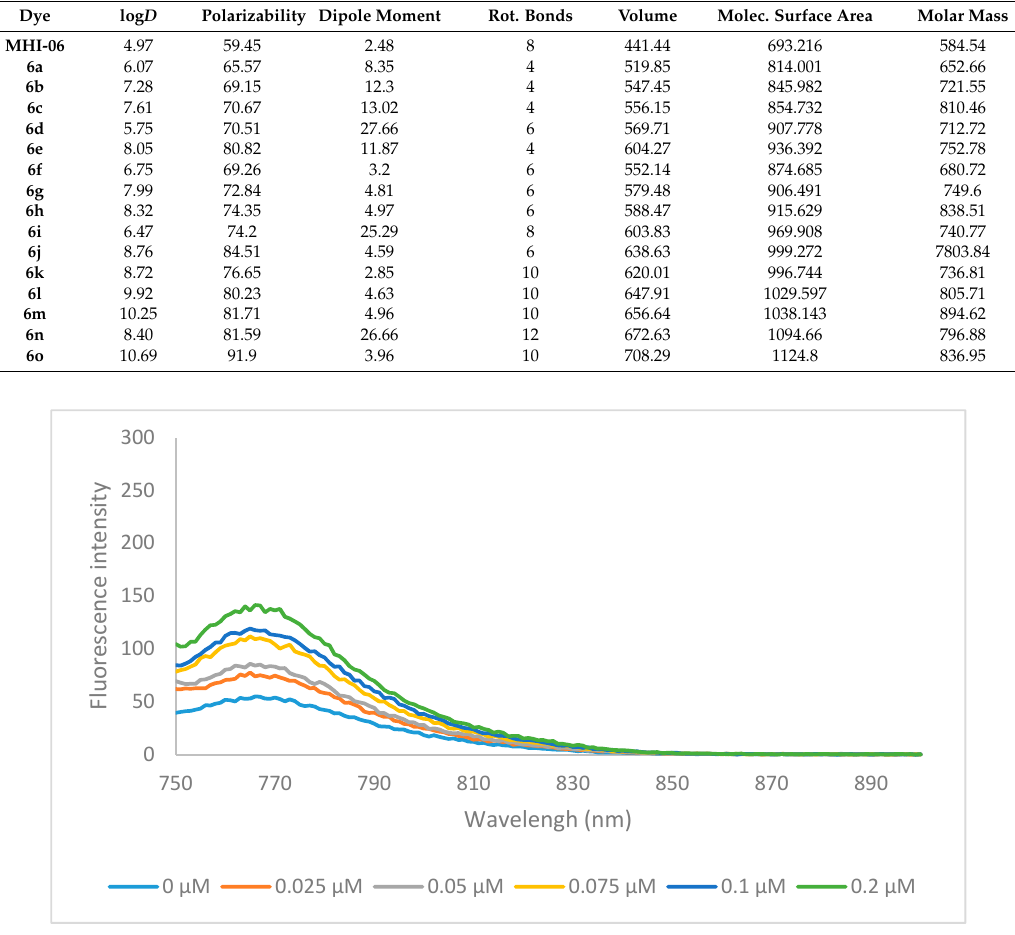
Figure 4. The emission specra of 6a (0.2 μ M) binding with various concentration of HSA, in PBS buffer at excitation wavelength of 740 nm.